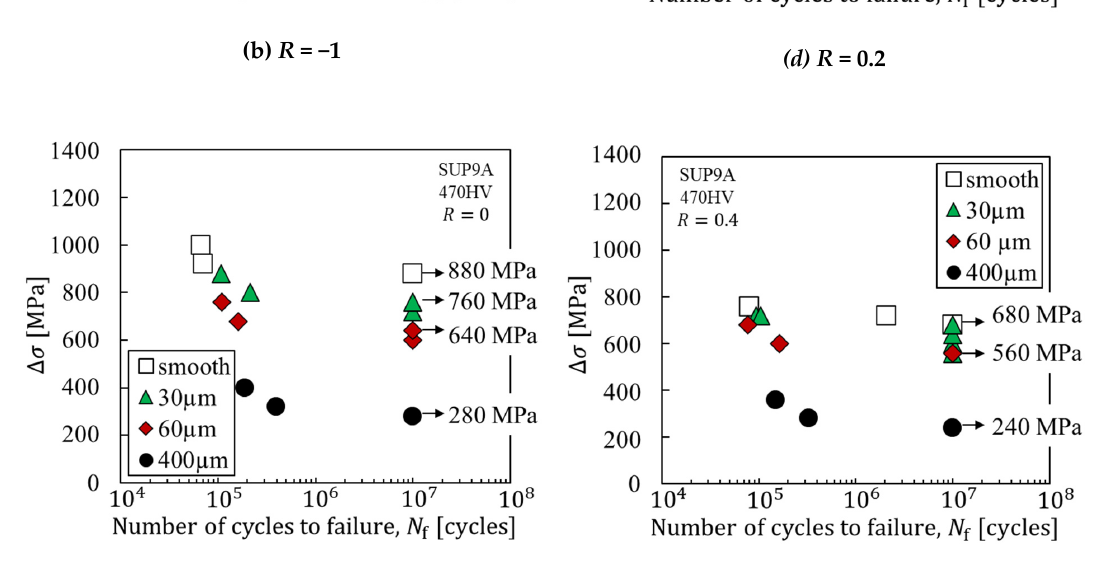
Figure 5. S–N curves for plane-bending fatigue tests. ( a ) R = − 2, ( b ) R = − 1, ( c ) R = 0, ( d ) R = 0.2, ( e ) R = 0.4. Table 2. Ratios of the fatigue limits of the slit and smooth specimens Δ(cid:2026) (cid:2933) /Δ(cid:2026) (cid:2933)(cid:2868) .